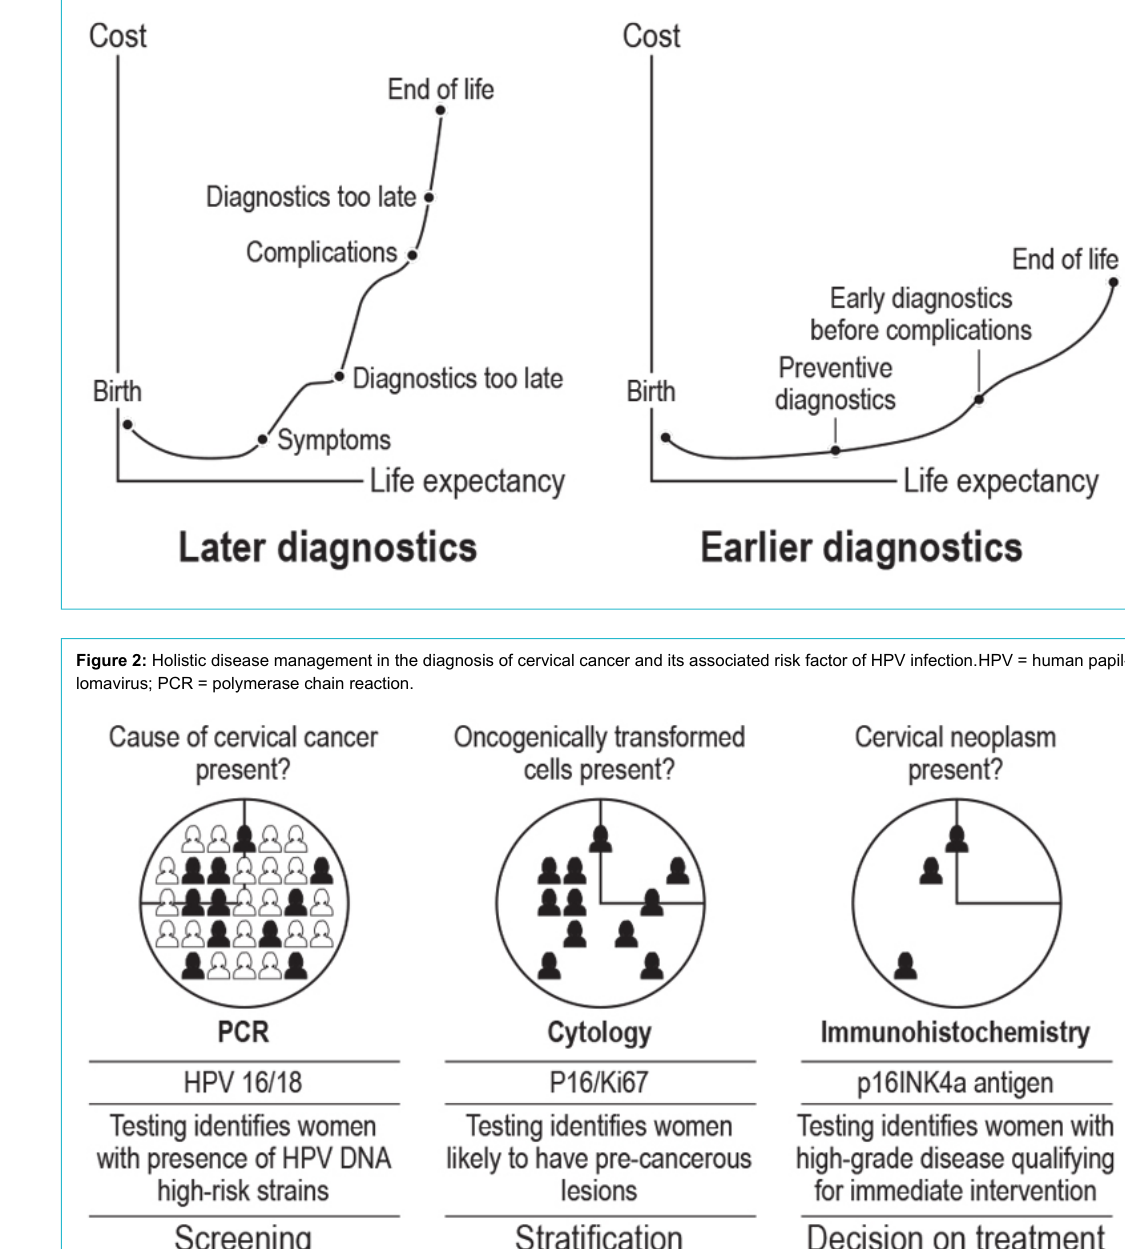
Figure 1: Generic diagram of the consequences of early vs late diagnostic measures with regard to life expectancy and associated costs.